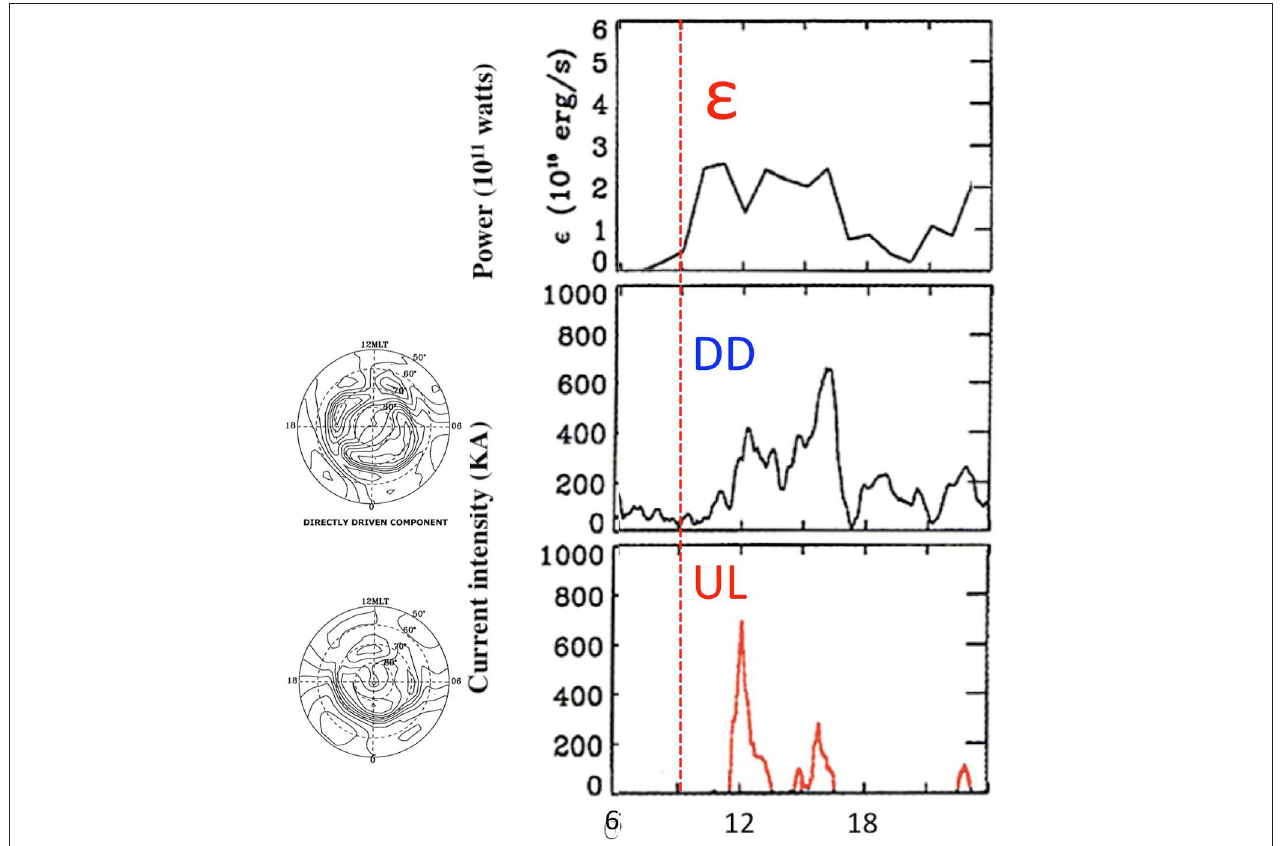
FIGURE 7 | The relationship among the power P ( = ε /8 π ), the directly driven (DD) current and the unloading (UL) current in the ionosphere; both the DD and UL current patterns are also shown (Akasofu).